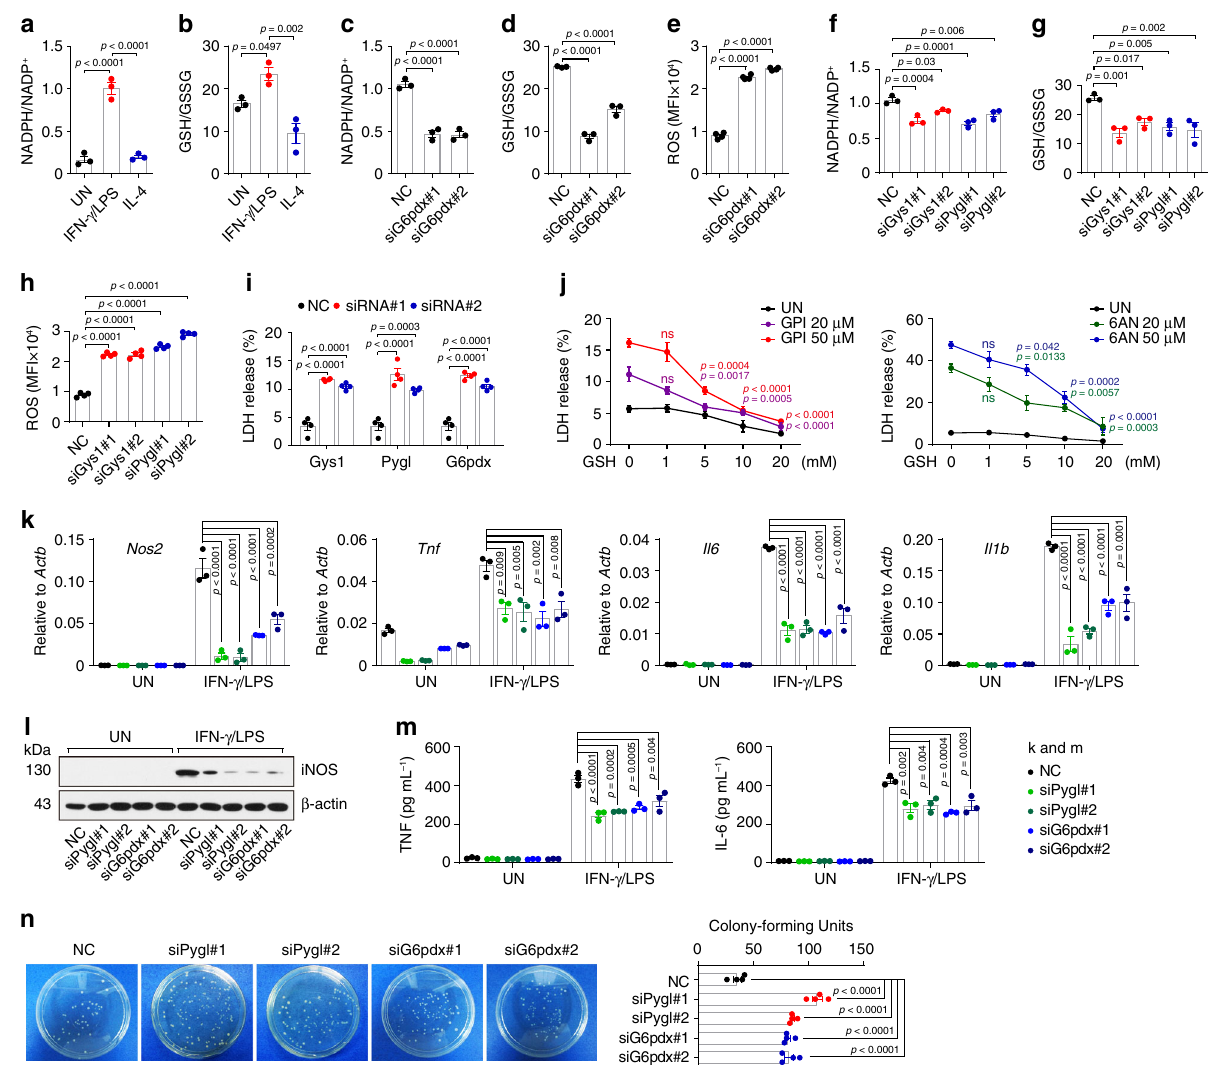
Fig. 3 PPP regulates macrophage phenotype, function and survival. a , b NADPH/NADP + ( a ) and GSH/GSSG ( b ) ratio in untreated, IFN- γ /LPS or IL-4 treated BMDMs were analyzed. c – e G6pdx siRNA transfected BMDMs were stimulated with IFN- γ /LPS for 24 h, NADPH/NADP + ( c ), GSH/GSSG ( d ) and ROS ( e ) were analyzed. MFI, mean fl uorescence intensity. f – h Gys1 or Pygl siRNA transfected BMDMs were stimulated with IFN- γ /LPS for 24 h, NADPH/ NADP + ( f ), GSH/GSSG ( g ) and ROS ( h ) were analyzed. i Gys1 , Pygl or G6pdx siRNA transfected BMDMs were stimulated with IFN- γ /LPS for 24 h, lactic dehydrogenase (LDH) release was analyzed. j BMDMs were pretreated with GPI or 6AN for 30 min prior to stimulation with IFN- γ /LPS ± GSH (0, 1, 5, 10, 20 mM) for 36 h, and LDH release was analyzed. k – m Pygl or G6pdx siRNA transfected BMDMs were stimulated with or without IFN- γ /LPS for 24 or 36 h, Nos2 , Tnf , Il6, and Il1b expression was determined by real-time PCR ( k ), iNOS, TNF and IL-6 expression was determined by western blot ( l ) and ELISA ( m ). n Pygl or G6pdx siRNA transfected BMDMs were stimulated with IFN- γ /LPS for 24 h and incubated with E.coli at ratio 1:1 for 3 h, then the E.coli was collected, coated and cultured with ampicillin-resistant agarose solid medium at 37 °C for 36 h, followed by colony-forming units count. Data are presented as mean ± SEM of n = 3 biologically independent experiments ( a – d , f , g , j , k , and m ) or n = 4 biologically independent experiments ( e , h , i and n ). P values were calculated using one-way